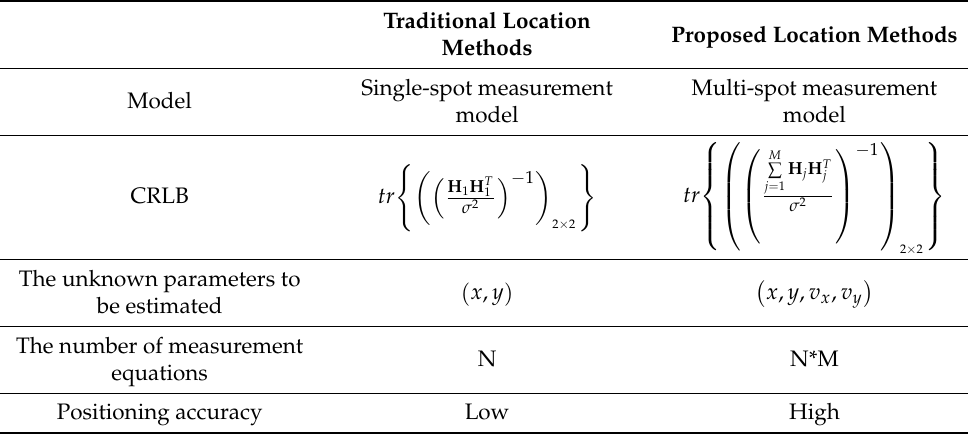
Table 1. Comparison between the traditional and proposed location methods.